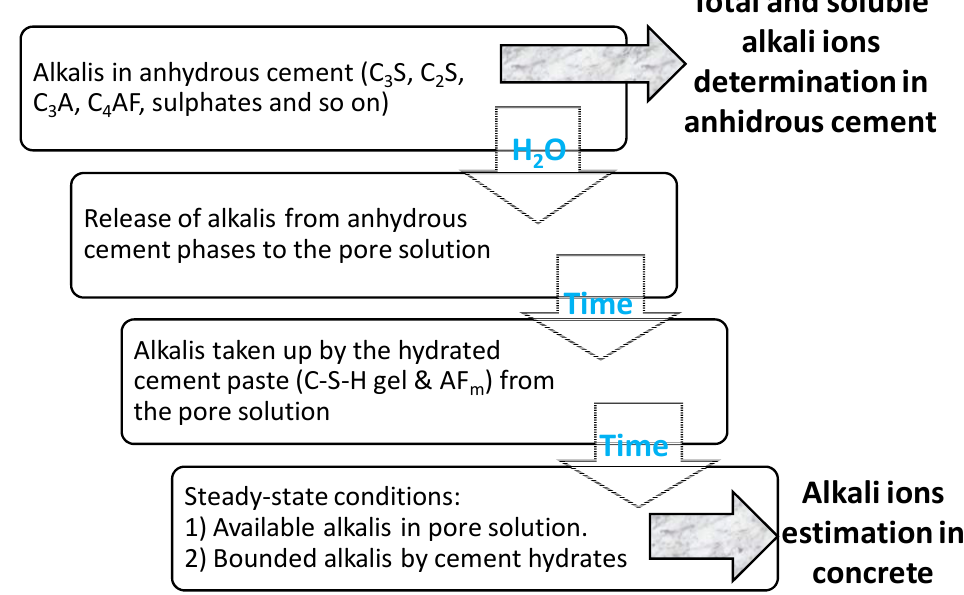
Figure 2. Procedure proposed to determine the available alkali ions in the common Portland cement paste pore solution, in concrete to be used in engineered barriers for waste confinement.